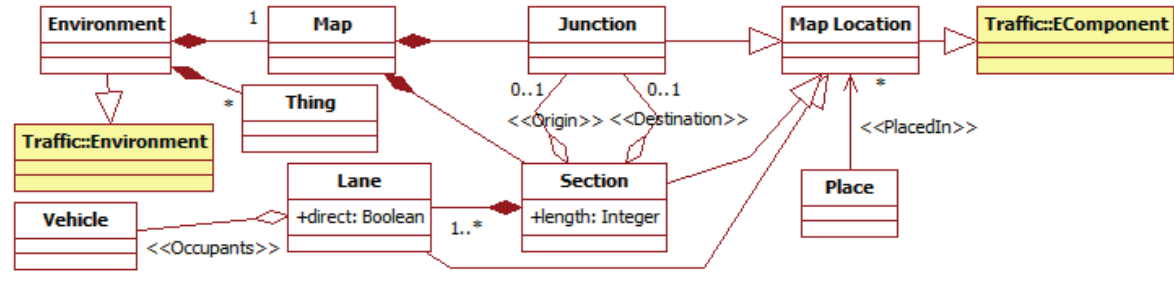
Figure 6. Partial ITS metamodel. Environment related